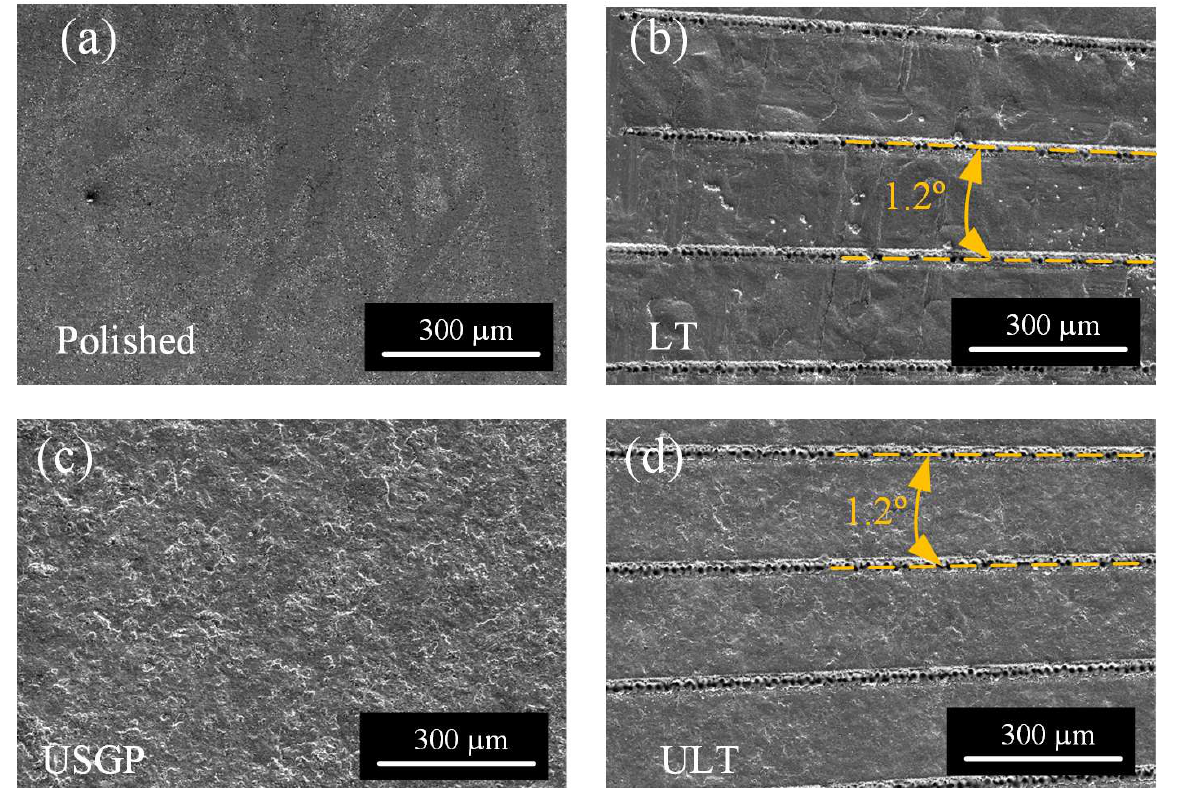
Figure 2. SEM topography of polished ( a ), LT ( b ), USGP ( c ), and ULT ( d )